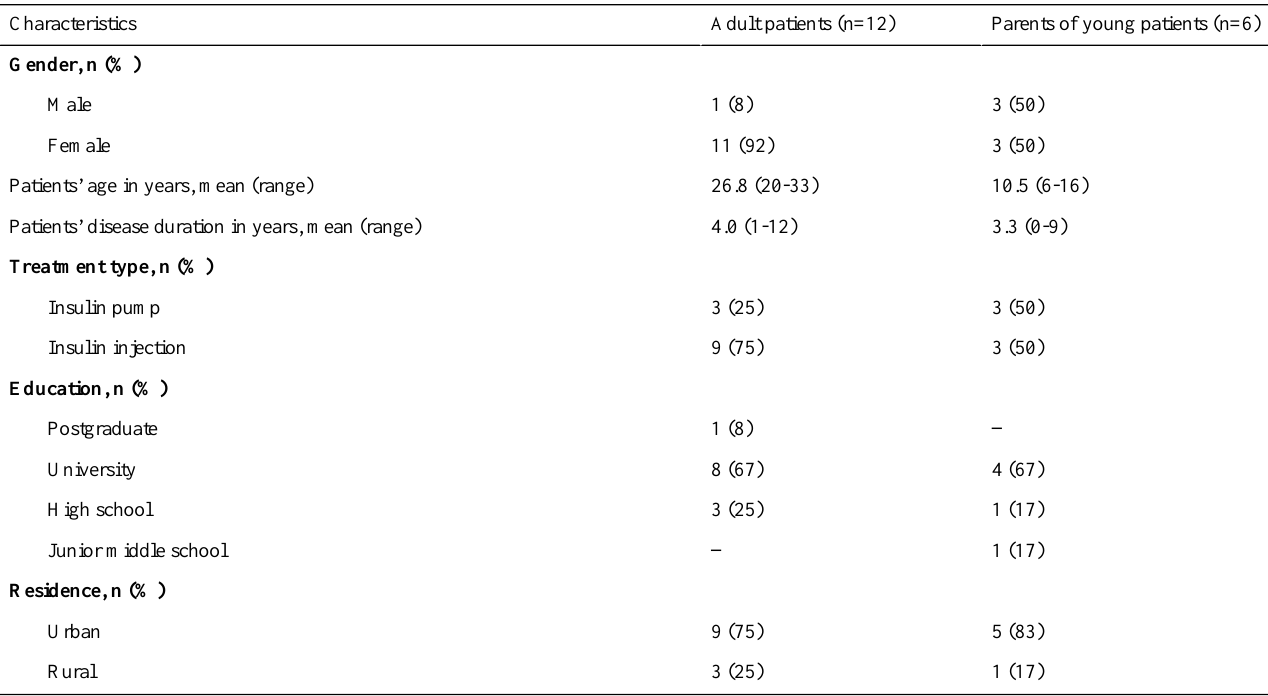
Table 2. Characteristics of the interviewees.